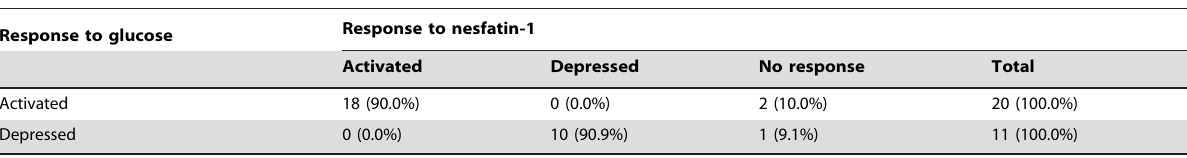
Table 3. Effects of nesfatin-1 on glucosensing neurons in DVC in vitro